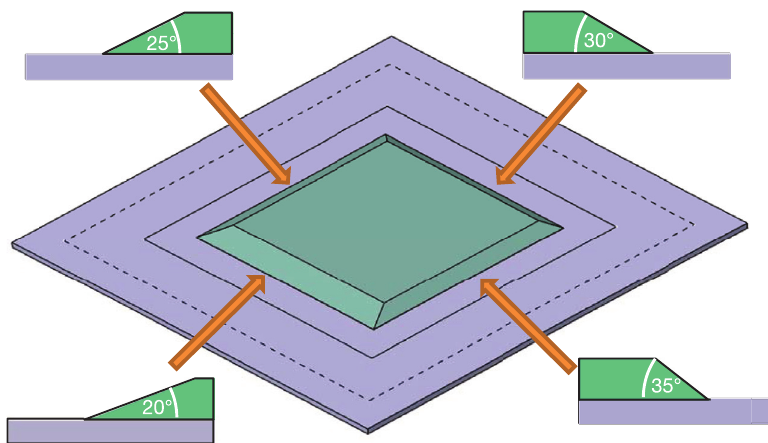
Figure 9 Tool layout for experimental testing of